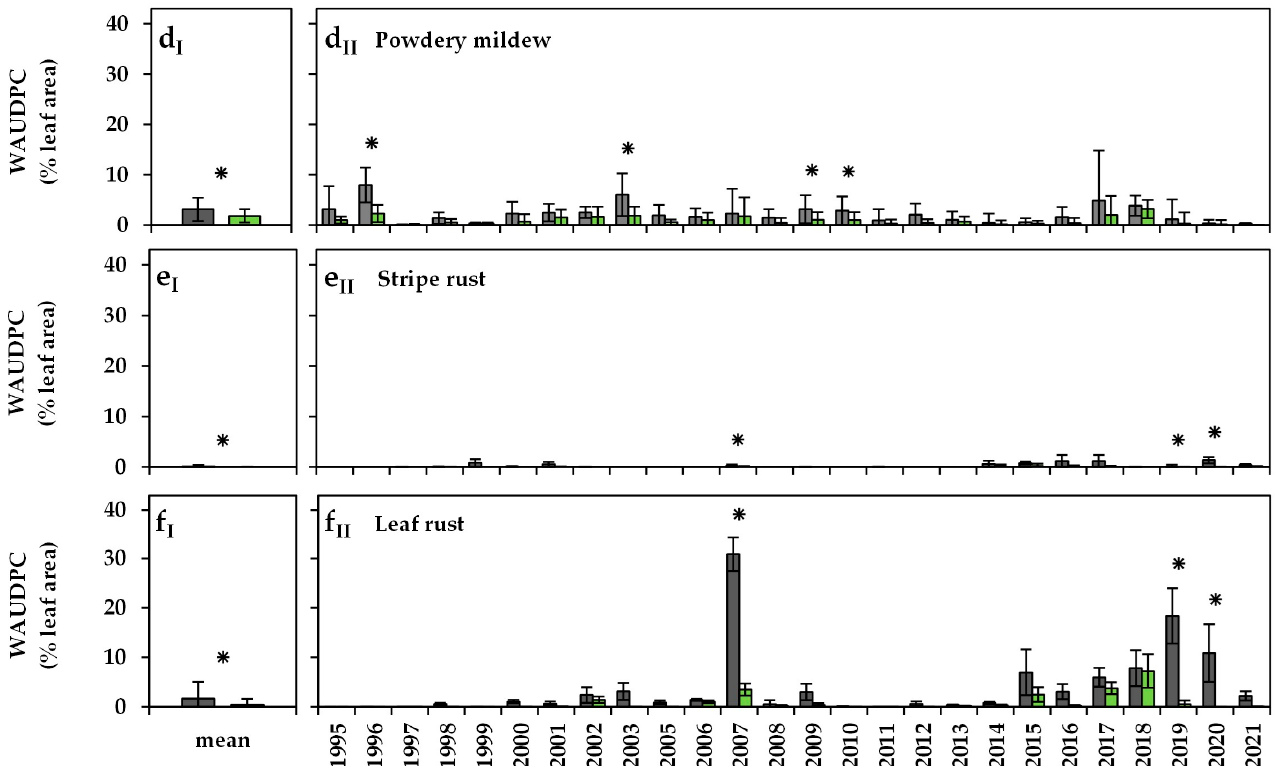
Figure 2. Total ( a I – f I ) and annual ( a II – f II ) weighted disease severities (WAUDPC; F-0 70%; F-1 20%; F-2 10%; F-3 to F-6 0%) of ( a ) Septoria tritici blotch (number of pycnidia), ( b ) glume blotch (number of pycnidia), ( c ) tan spot (percentage of leaf area affected), ( d ) powdery mildew (percentage of leaf area affected), ( e ) stripe rust (percentage of leaf area affected), and ( f ) leaf rust (percentage of leaf area affected) of the untreated control (black bars) and IPM treatment (green bars) of winter wheat (cultivar “Ritmo”) of the eight trial locations in northern Germany from 1995 to 2021. Significant ( p ≤ 0.05) differences treatment differences are marked with *.